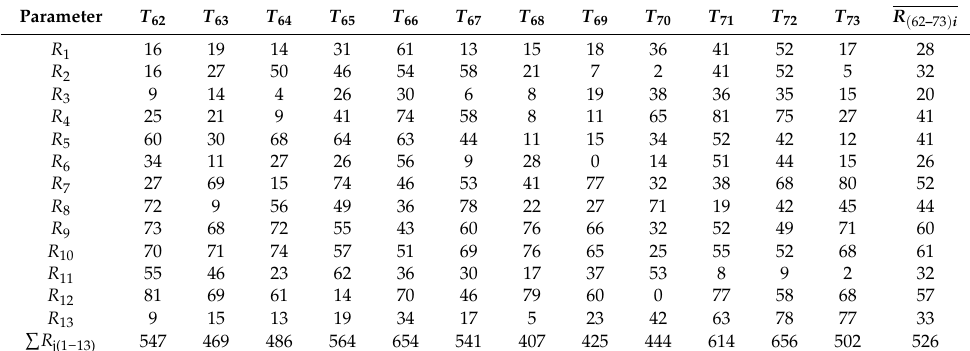
Table A23. Ranking of T j territories on land activity, Siberian Federal District.